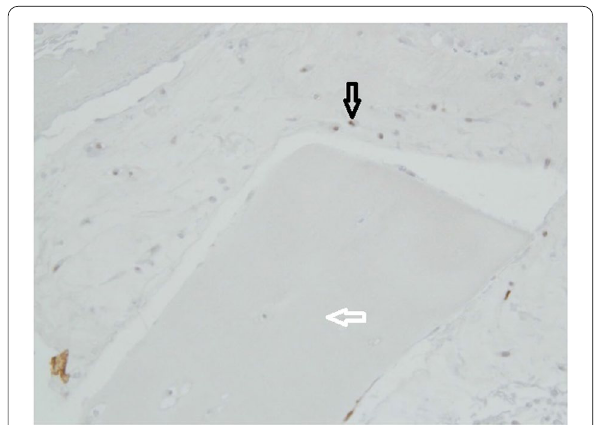
Fig. 4 Some week positive signals for SOX‑9 stained cells in the newly formed cartilage matrix from the digested particulated cartilage (marked with black arrow, well 10). Minced cartilage in the middle (marked with white arrow). Poor adhesion of the newly formed matrix with the piece of